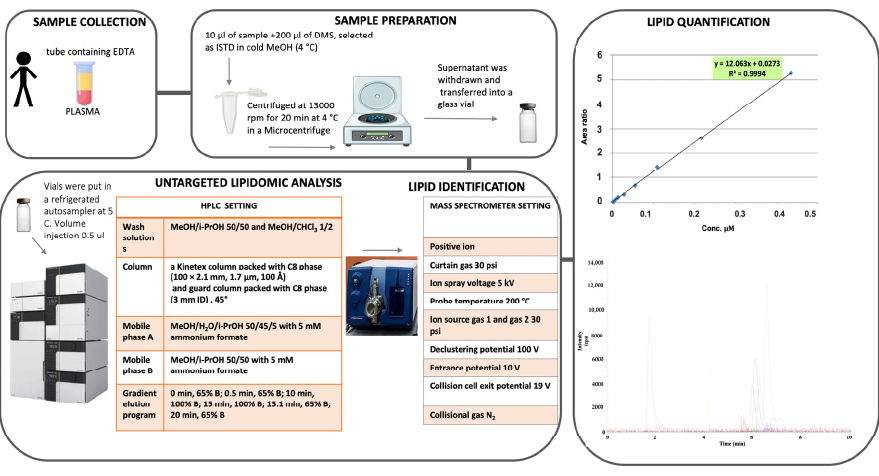
Figure 3. Plasma processing and HPLC-MS/MS setting and